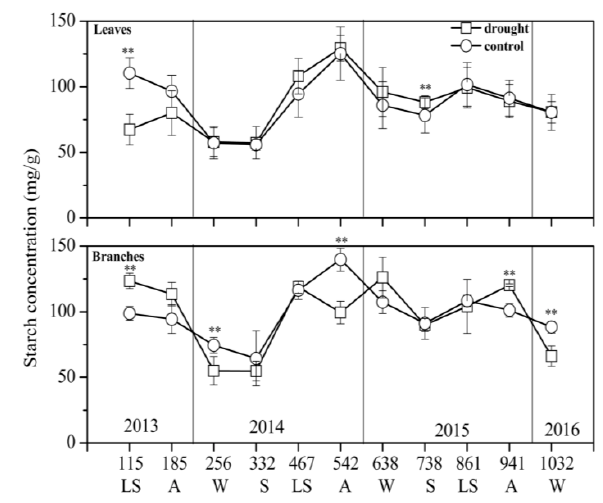
Figure 6. Starch concentrations in the leaves and branches of Pinus massoniana under control and drought treatments (mean ± SD). Samples were collected in late summer (LS), autumn (A), winter (W), and late spring (S) from 2013 to 2016. Variables marked with asterisks indicate a significant difference between the control and drought groups (** p < 0.01, * p < 0.05).